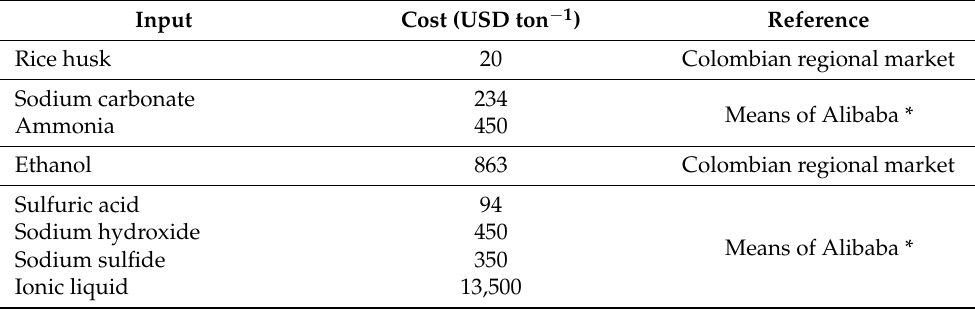
Table 10. Feedstock and chemical reagent cost.